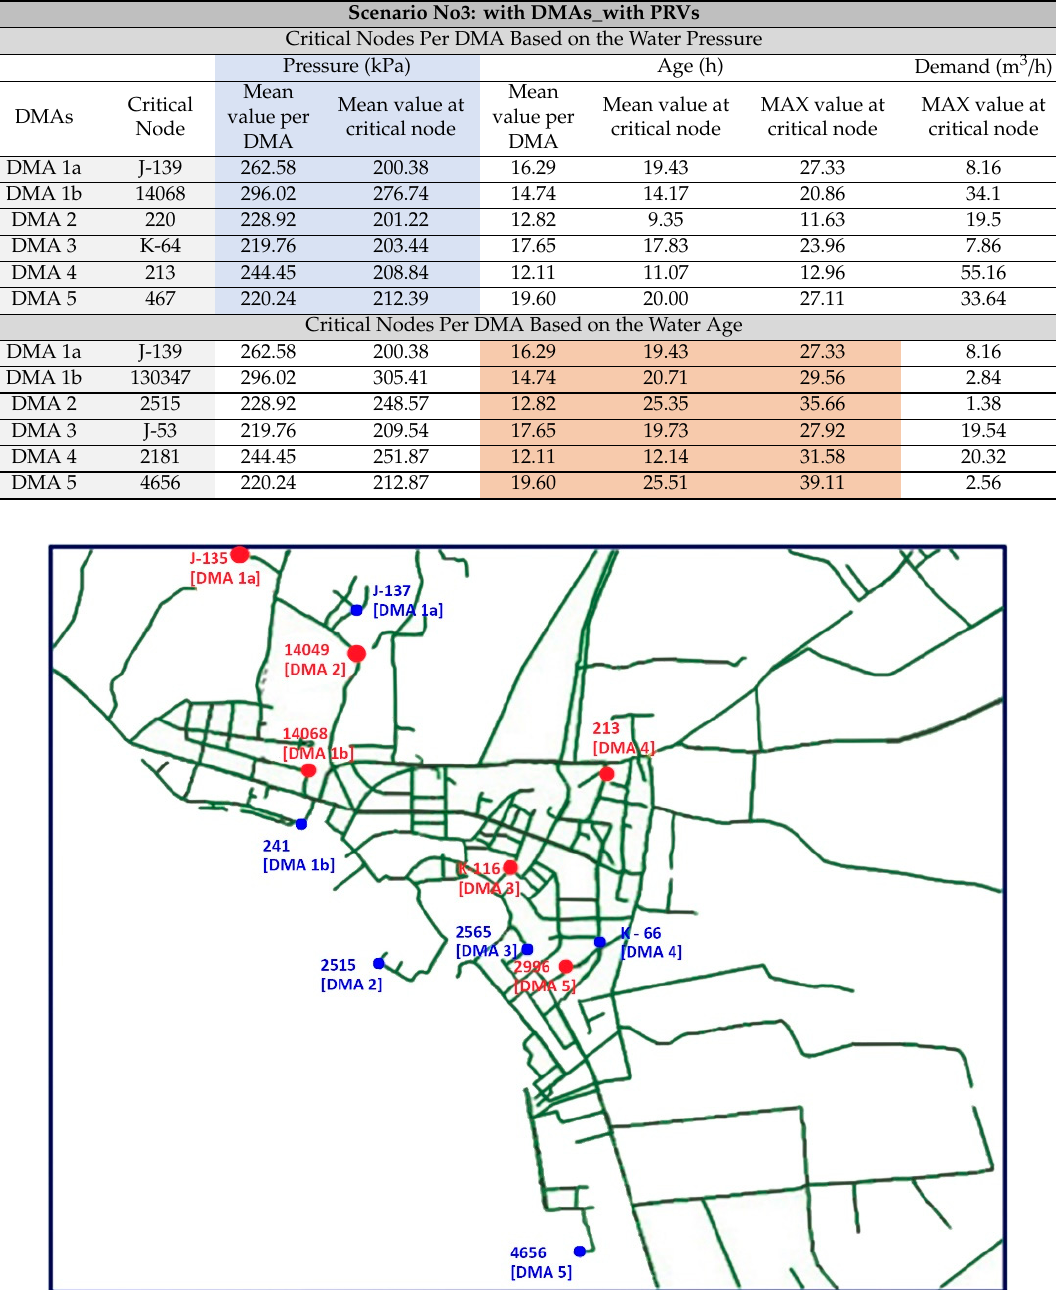
Figure 3. Scenario No1_Pressure critical nodes (red) vs. Age critical nodes (blue). Table 2. Scenario No2 (withDMAs_no PRVs): a) Critical nodes per DMA based on the water pressure. Respective water age and water demand values; b) Critical nodes per DMA based on the water age. Respective water pressure and demand values.